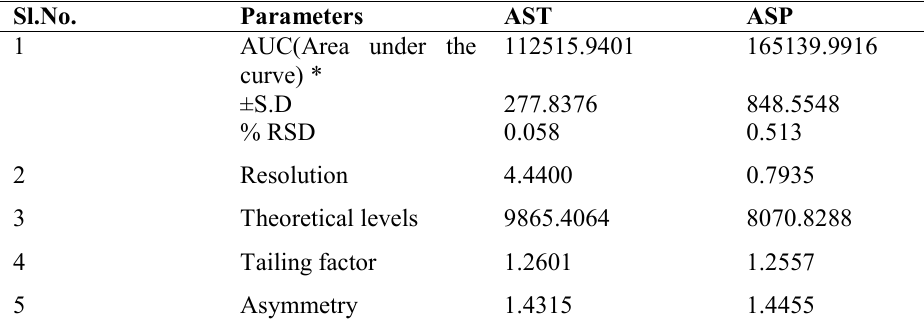
Table: 1. Study of System Suitability